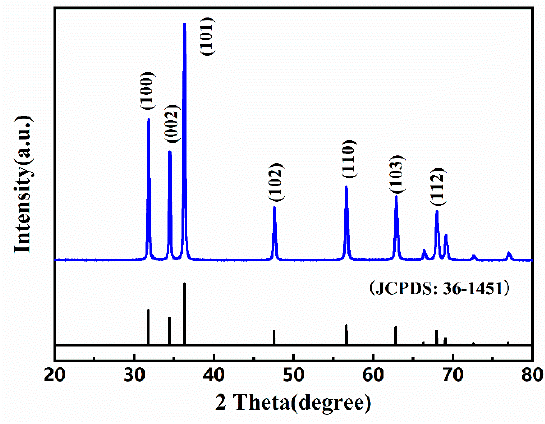
Figure 2. X-ray di ff raction (XRD) pattern of the as-prepared ZnO hollow Figure 2. X-ray diffraction (XRD) pattern of the as-prepared ZnO hollow microspheres.